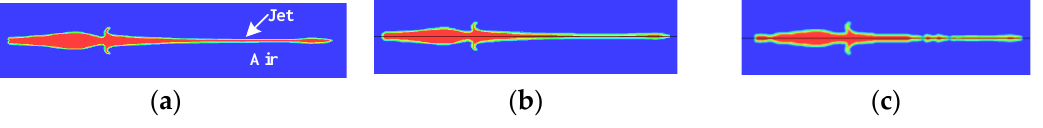
Figure 6. Jet forms of different mesh sizes: ( a ) 0.5 mm; ( b ) 0.75 mm; ( c ) 1 mm.